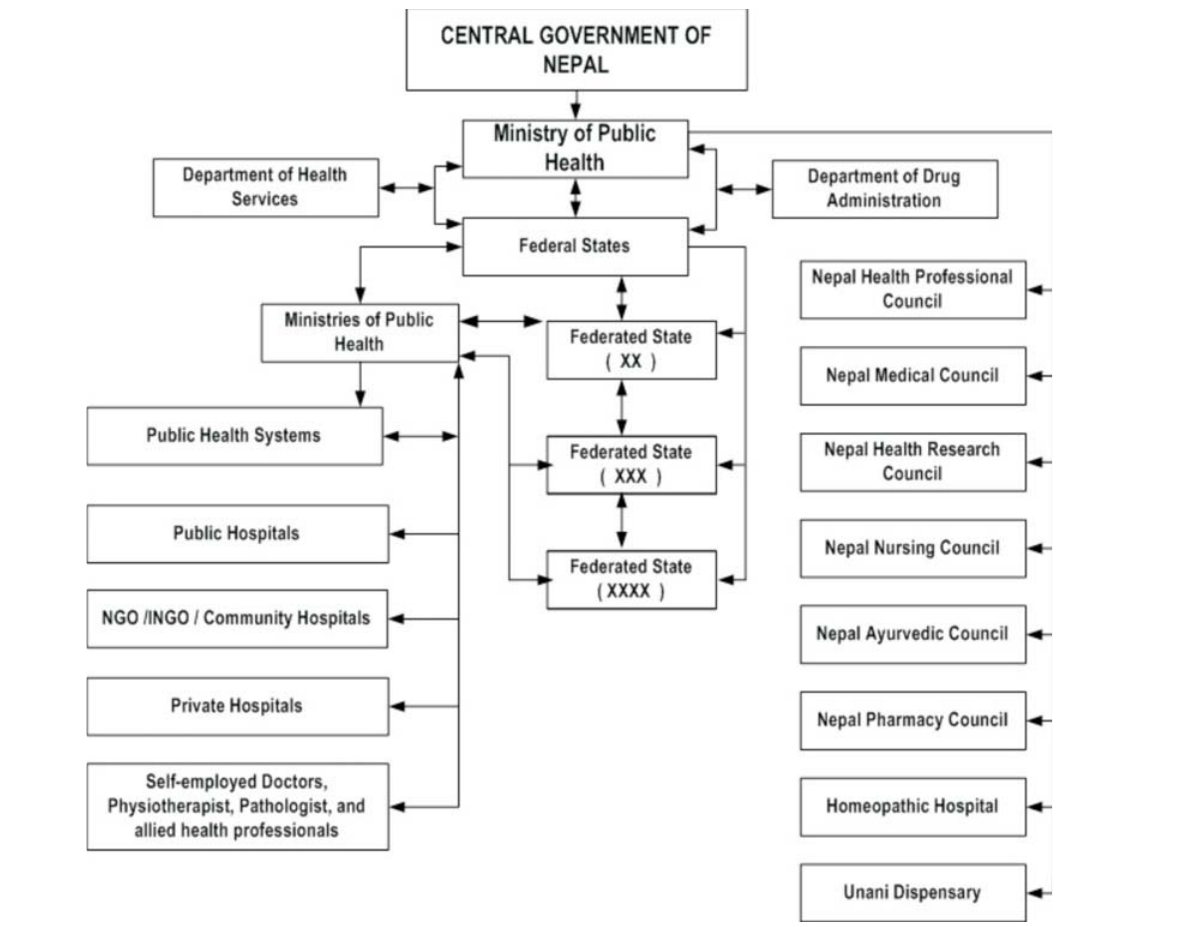
Figure 1. Projected federal set up of health care organization -